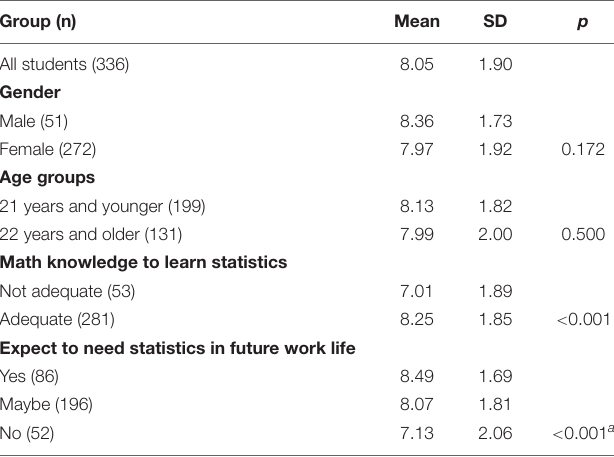
TABLE 3 | Mean statistics-related critical thinking scores at baseline.